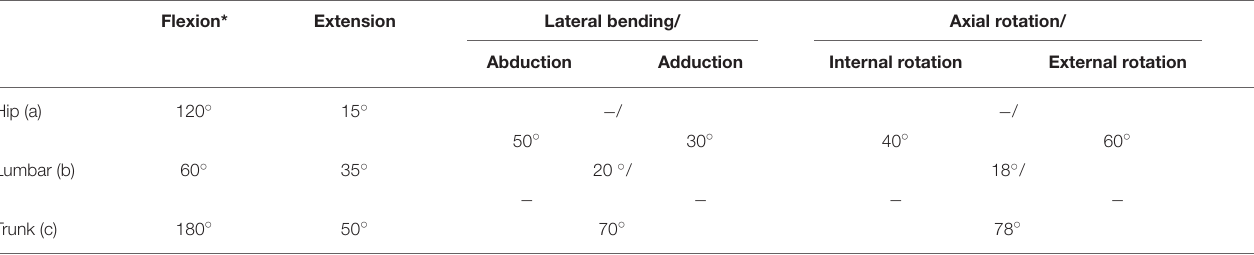
TABLE 1 | Range of motion of the hip, lumbar spine and the combination of the two: trunk angle (Magee, 2006): The definitions of the flexion angles (*) are shown in Figure 2A . Flexion* Extension Lateral